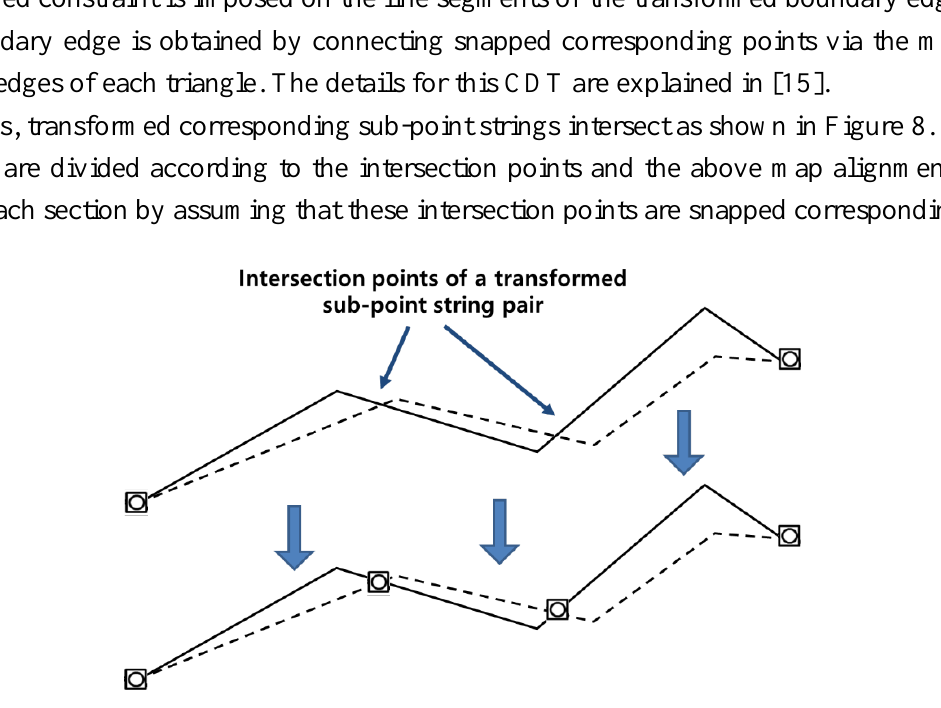
Figure 8. Polygon difference with intersection points of a transformed sub-point string